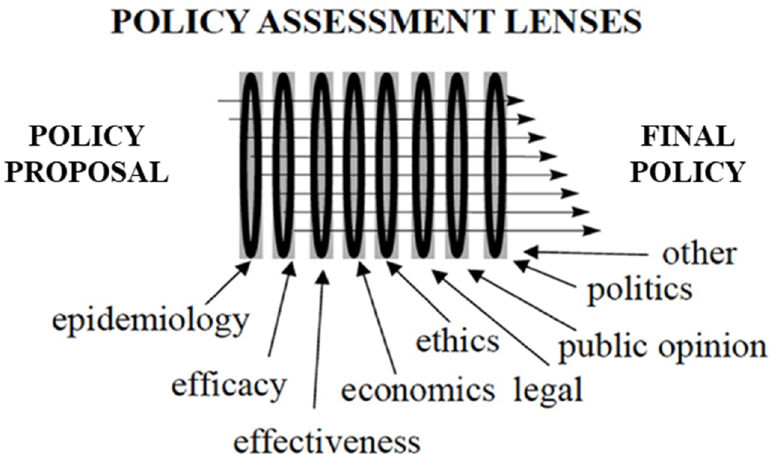
Figure 1: Framework for policy assessment and